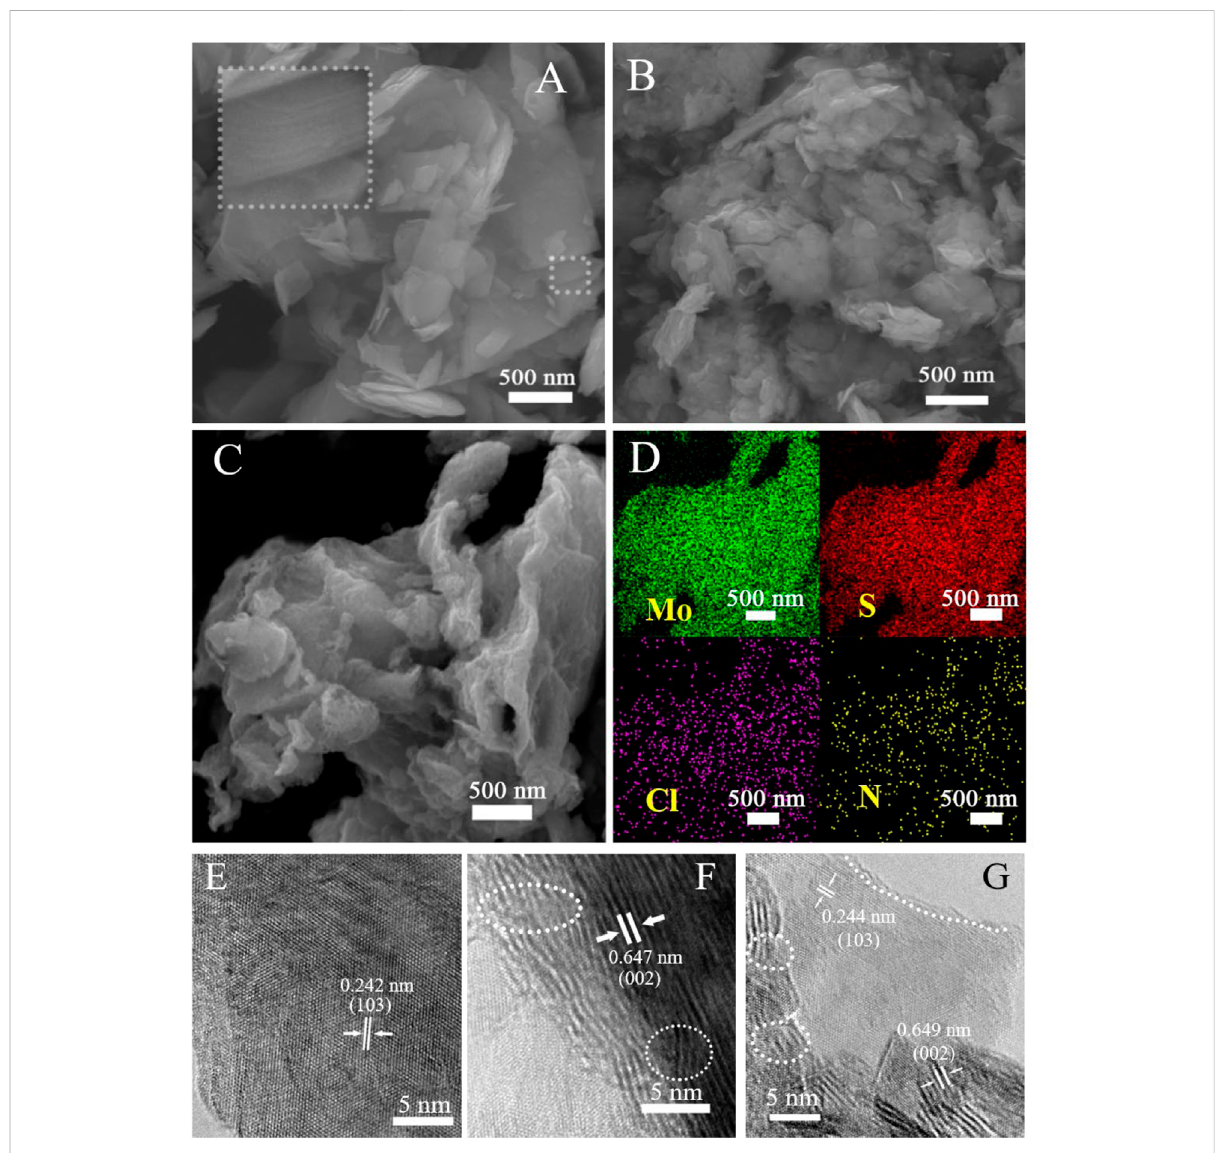
FIGURE 1 SEM images of (A) pristine MoS 2 , (B) BM-MoS 2 , and (C) N/Cl-MoS 2 . (D) EDS elemental mapping of N/Cl-MoS 2 from (C) . HR-TEM images of (E) pristine